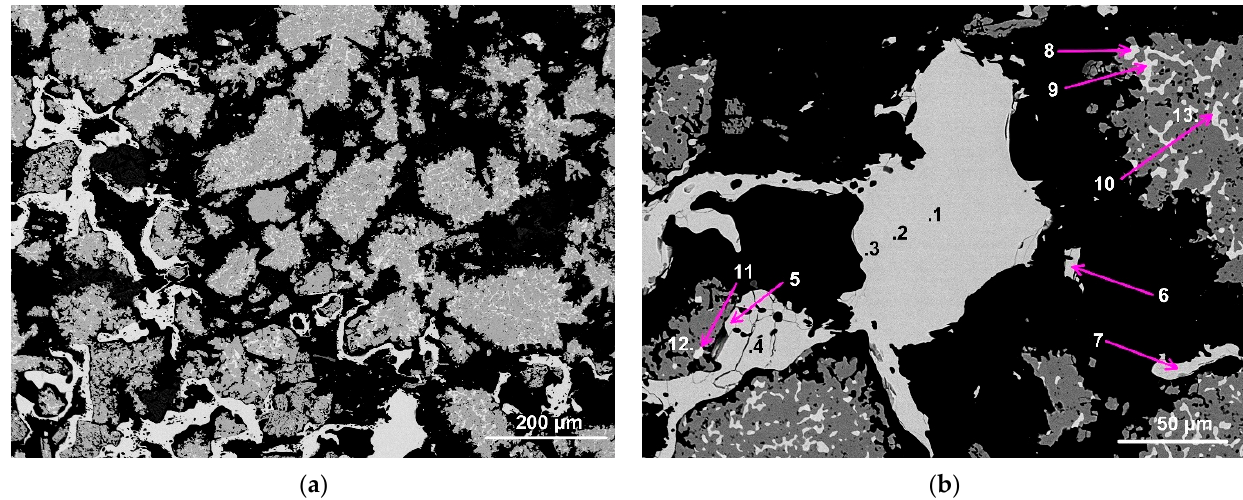
Figure 6. ( a ): Sample C BSE image: 1200 °C, 15% Fe addition; ( b ): Magnified s ample C analysis area BSE image: 1200 °C, 15% Fe addition; (grey = MnO, white = alloy). Table 3. SEM-WDS analyses of points in Figure 6b.